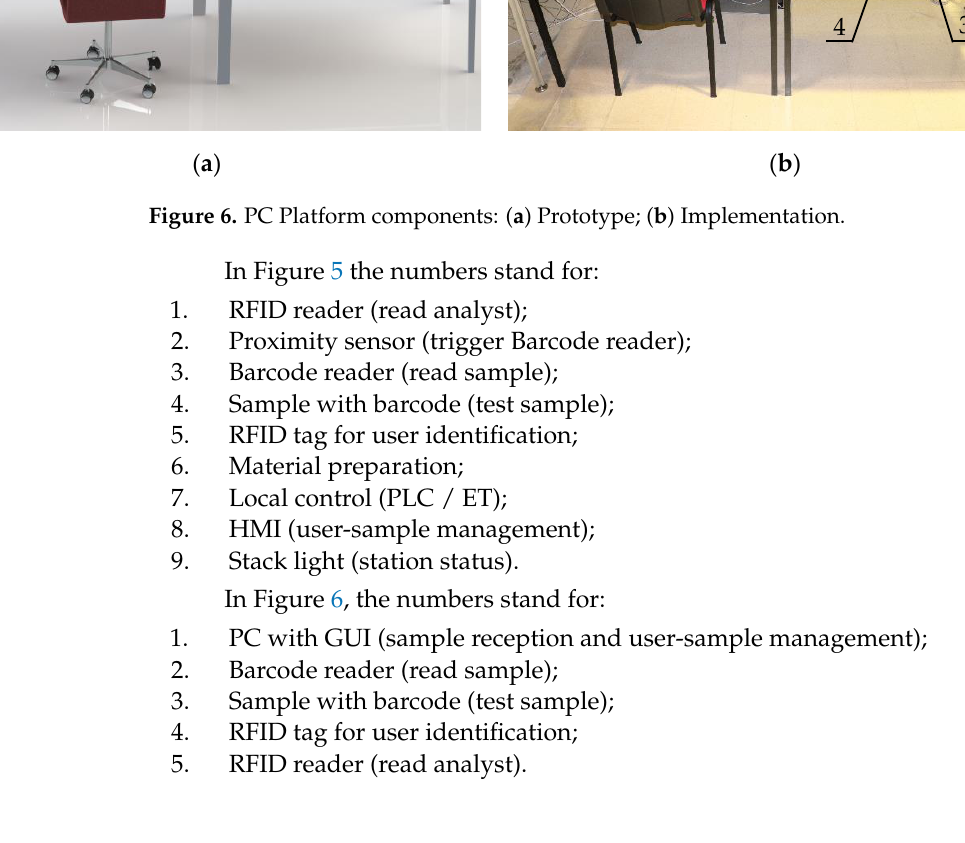
Figure 6. PC Platform components: ( a ) Prototype; ( b ) Implementation.